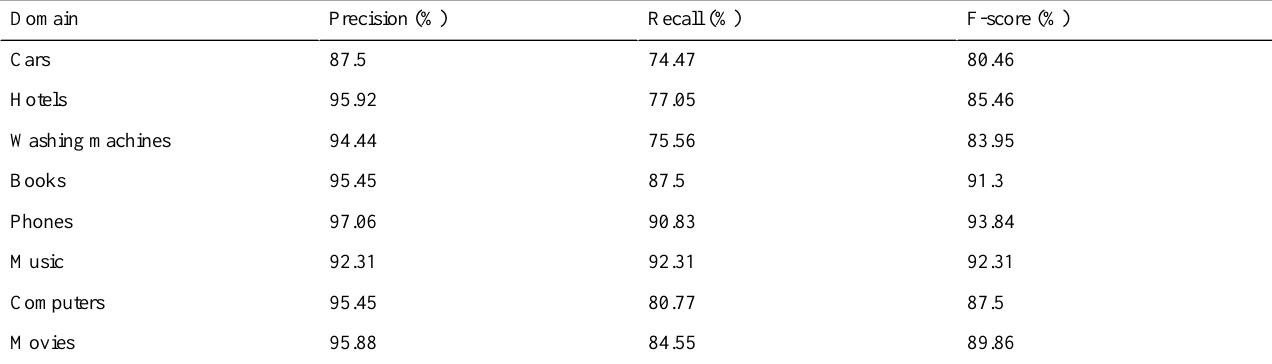
Table 22. NeuroNER Extended results of negation detection for the SFU ReviewSP-NEG data set.